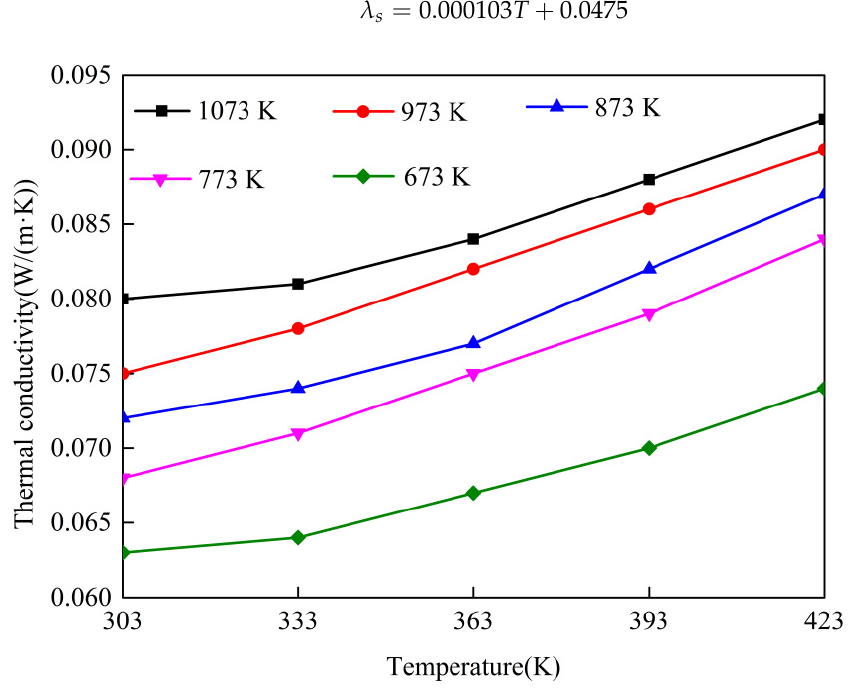
Figure 8. Variations of the thermal conductivity after expansion with temperature.